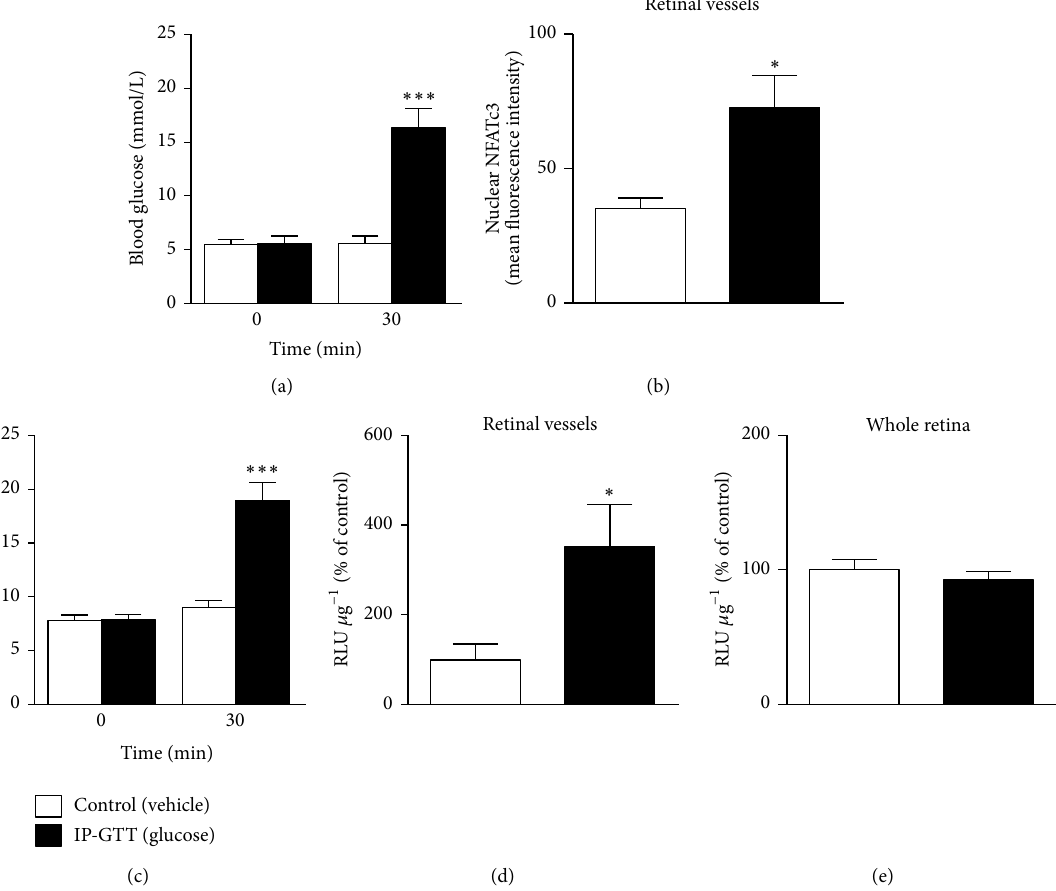
Figure 3: Acute hyperglycemia increases NFATc3 nuclear accumulation and NFAT-dependent transcriptional activity in retinal microvessels. (a) Blood glucose levels measured before and 30 min after an i.p. injection of glucose (2g/kg; IP-GTT, black bars) or saline (control, white bars) in BALB/c mice, 𝑁 = 7 -8 mice/group. (b) Summarized data from confocal immunofluorescence experiments in the mice described in (a), showing increased NFATc3 nuclear accumulation in the retinal endothelium of hyperglycemic mice when compared to controls. (c) Blood glucose levels measured before and 30 min after an i.p. injection of glucose (2g/kg; IP-GTT, black bars) or saline (control, white bars) NFAT-luc mice. (d)-(e) NFAT-dependent transcriptional activity in isolated retinal vessels (d) and whole retinas (e) in the NFAT-luc mice described in (c) measured 6 hours after i.p. injection of glucose or saline. Relative light units (RLU) in (d) and (e) were normalized to protein content and expressed as percentage of vehicle-treated control. 𝑁 = 7–12 mice/group. ∗ 𝑃 < 0.05 and ∗∗∗ 𝑃 < 0.001 versus normoglycemic control